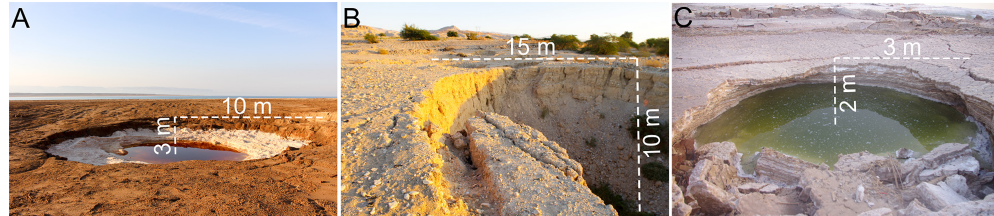
Figure 2. Sinkhole examples from the eastern shoreline of the Dead Sea. (a) Sinkhole with De / Di ∼ 0 . 15 formed in semi-consolidated lime- carbonate mud of the former Dead Sea bed. (b) Sinkhole with De / Di ∼ 0 . 33, formed in semi-consolidated sandy gravel (alluvial) sediment. Note the deep cracks and tilted blocks marginal to the sinkhole. (c) Sinkhole with De / Di ∼ 0 . 33 formed in semi- to well-consolidated salt material. Note the typical overhanging sides and pronounced cracks in the